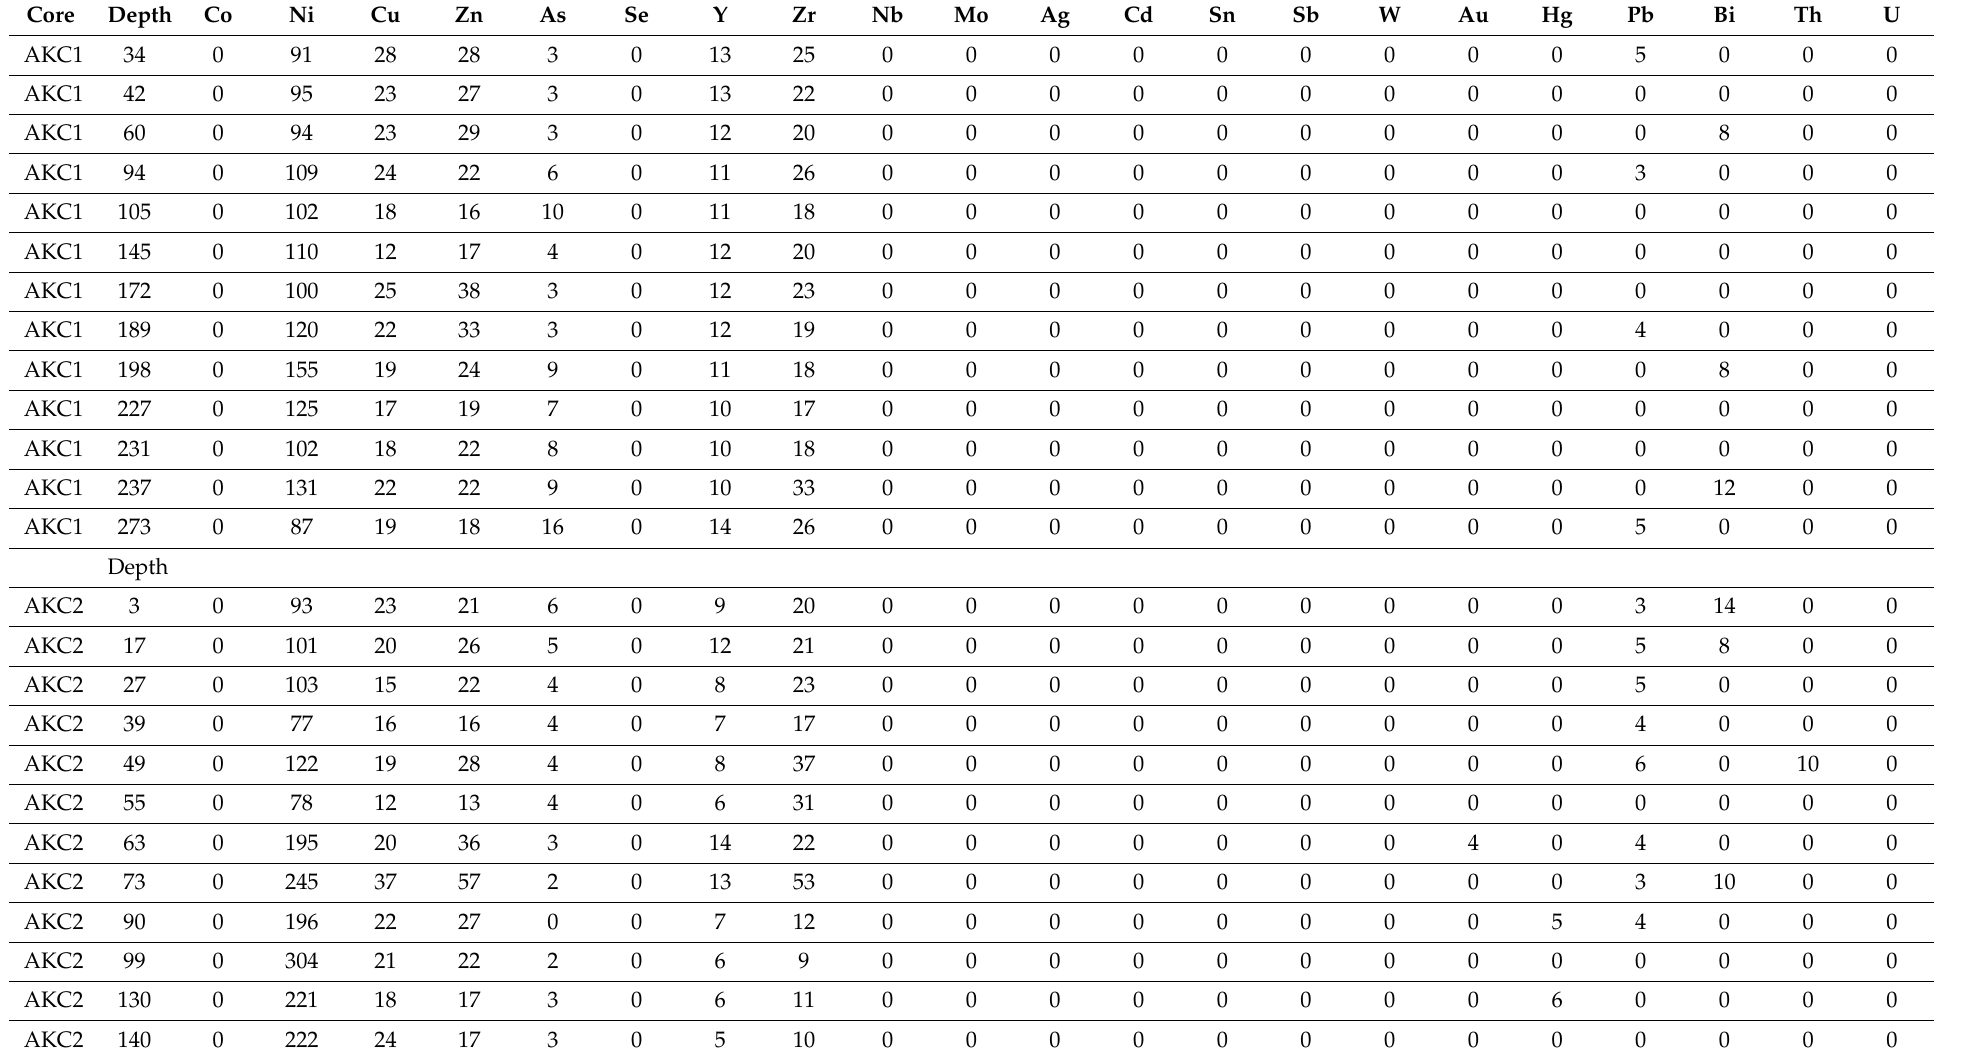
Table A2. Handheld XRF geochemistry of the studied cores (Co to U values in